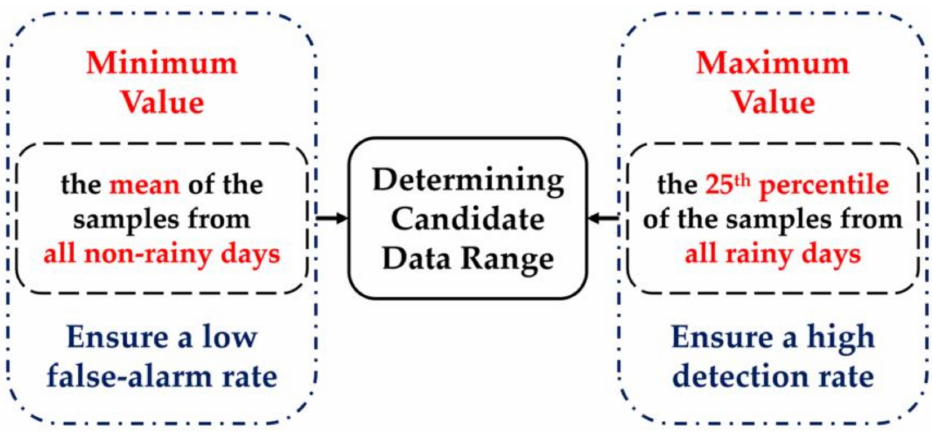
Figure 2. Schematic diagram for determining candidate data